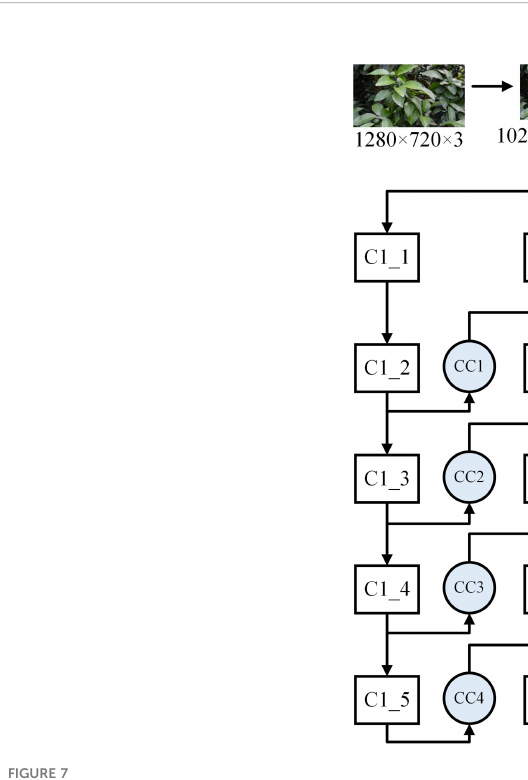
FIGURE 7 ResNet+CB-Net Network